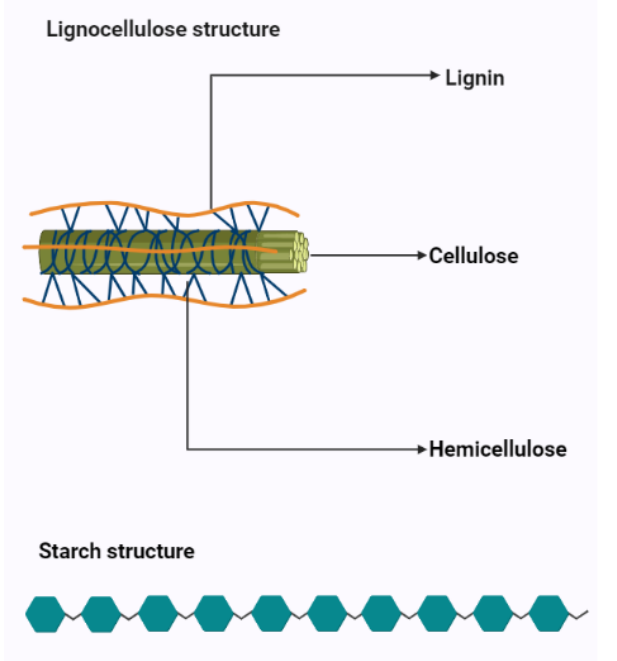
Figure 1. Pictorial diagram of chemical structures of starch and lignocellulose concerning main units in the structure.